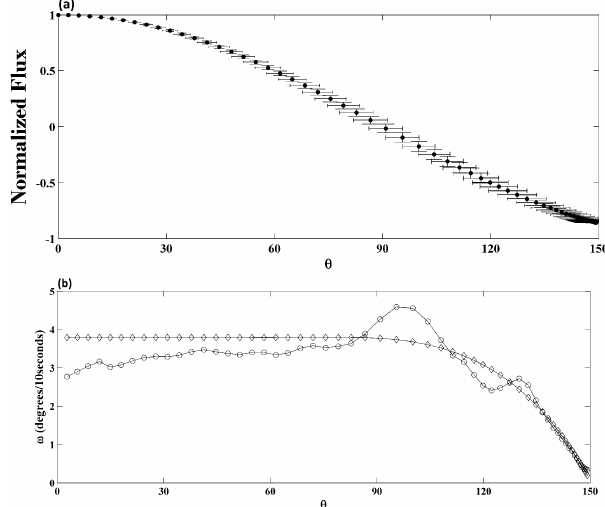
Figure 7. Upper panel: stacking results of 17 star-pointing (MES) observations during ascending phases. Lower pane: the diamond sign is the rotation of the spacecraft; the circle represents the motion inverted from BOS